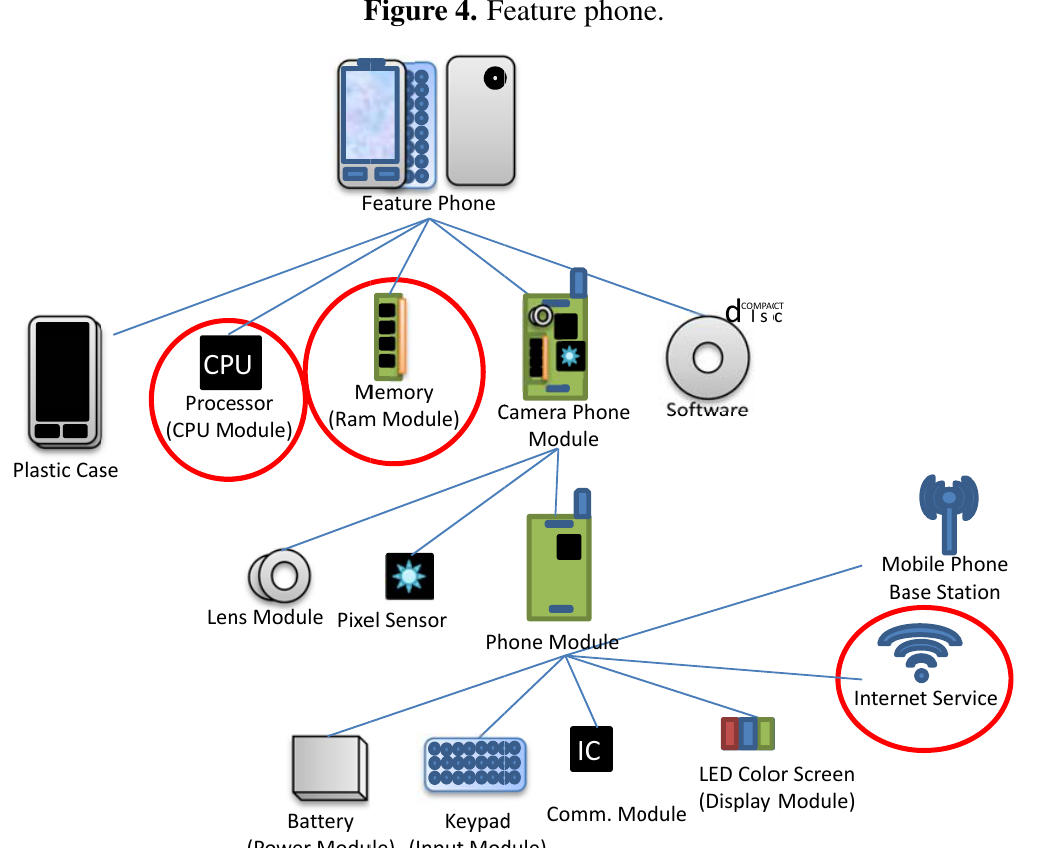
Figure 4. Feature